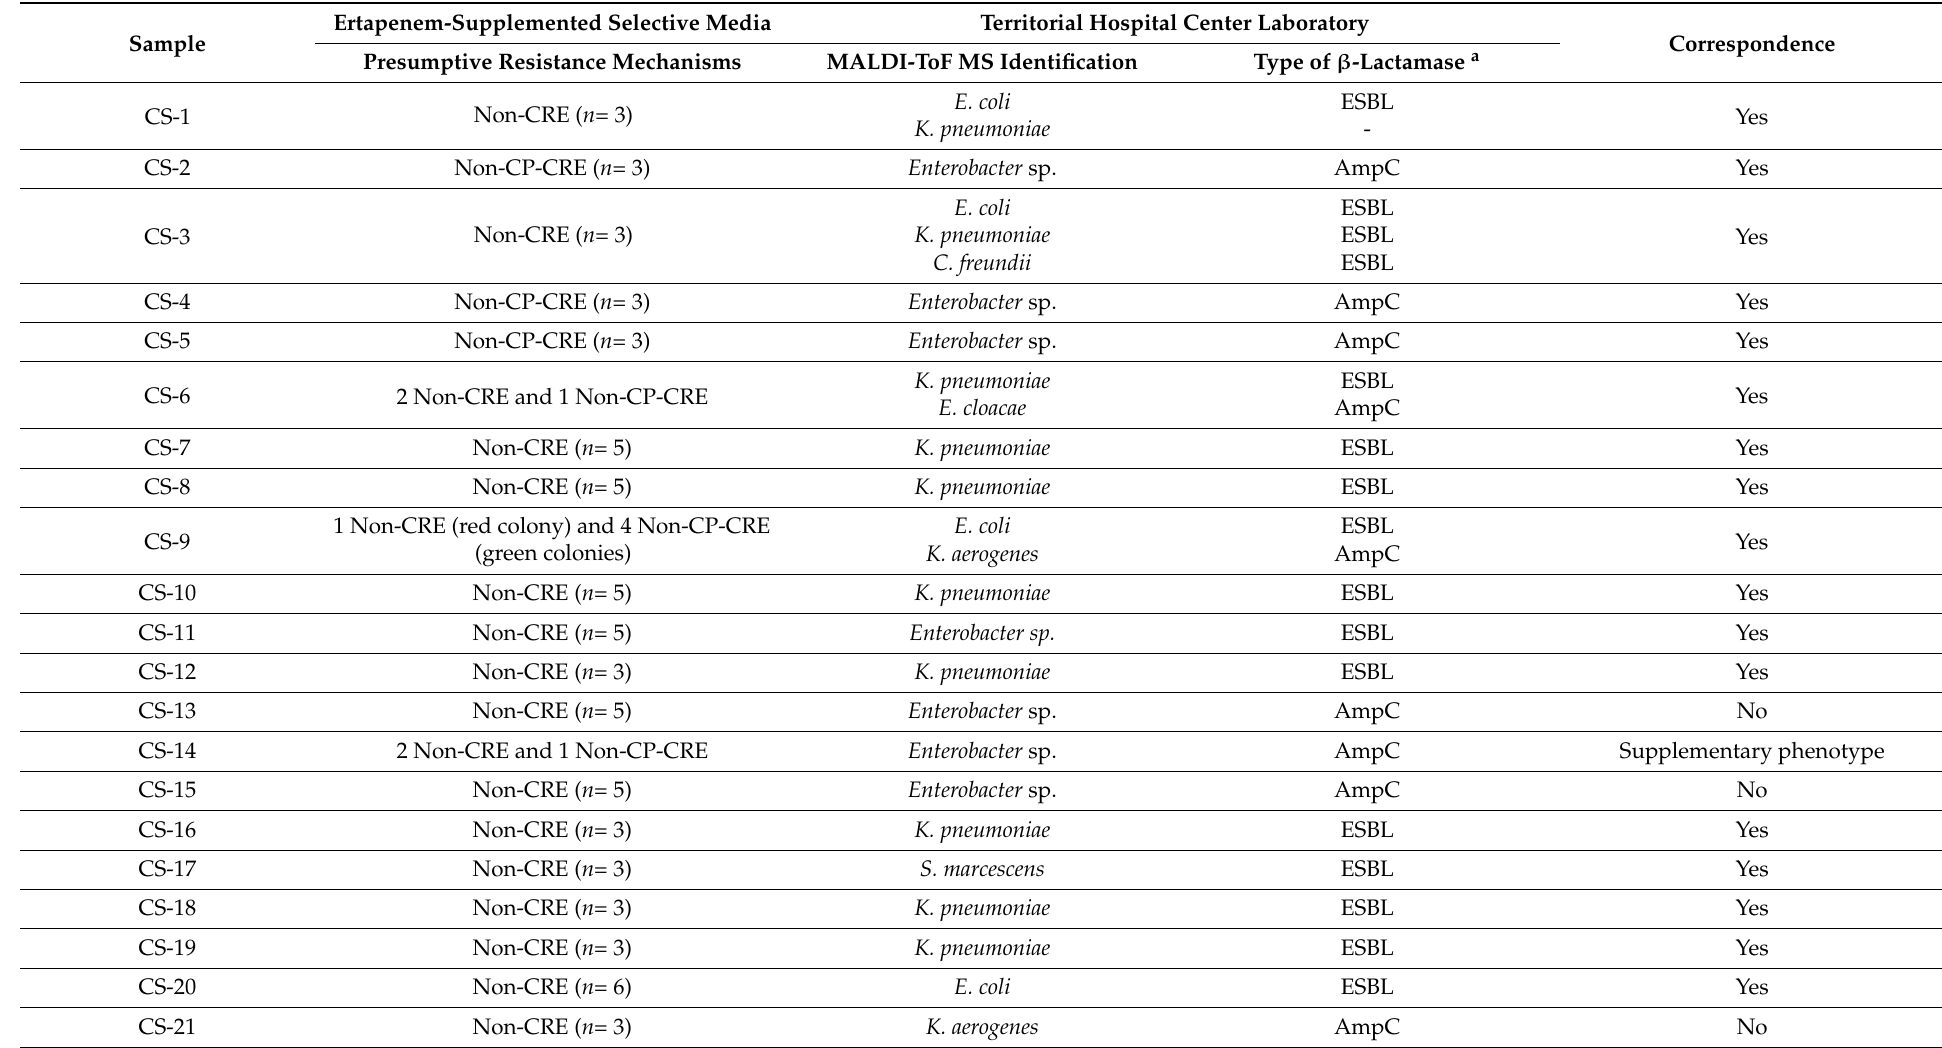
Table 2. Comparison of results obtained in Territorial Hospital Center laboratory with ertapenem culture